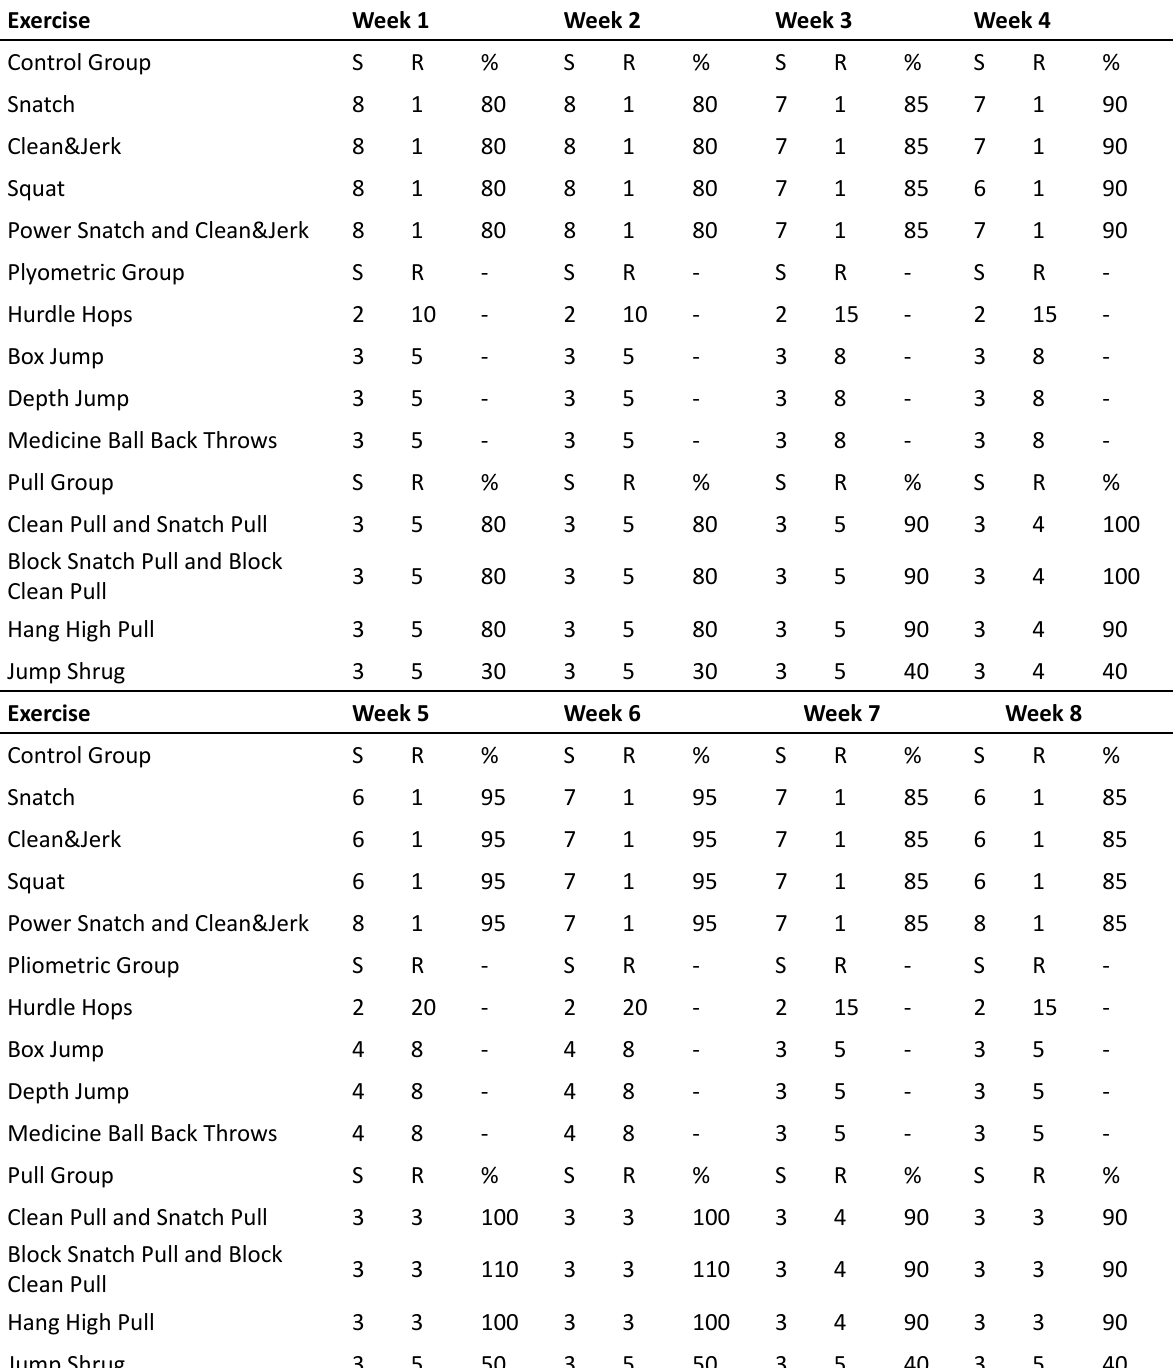
Table 2. Volume (Set / Repeat) and Intensity Rates of Training Programs Exercise